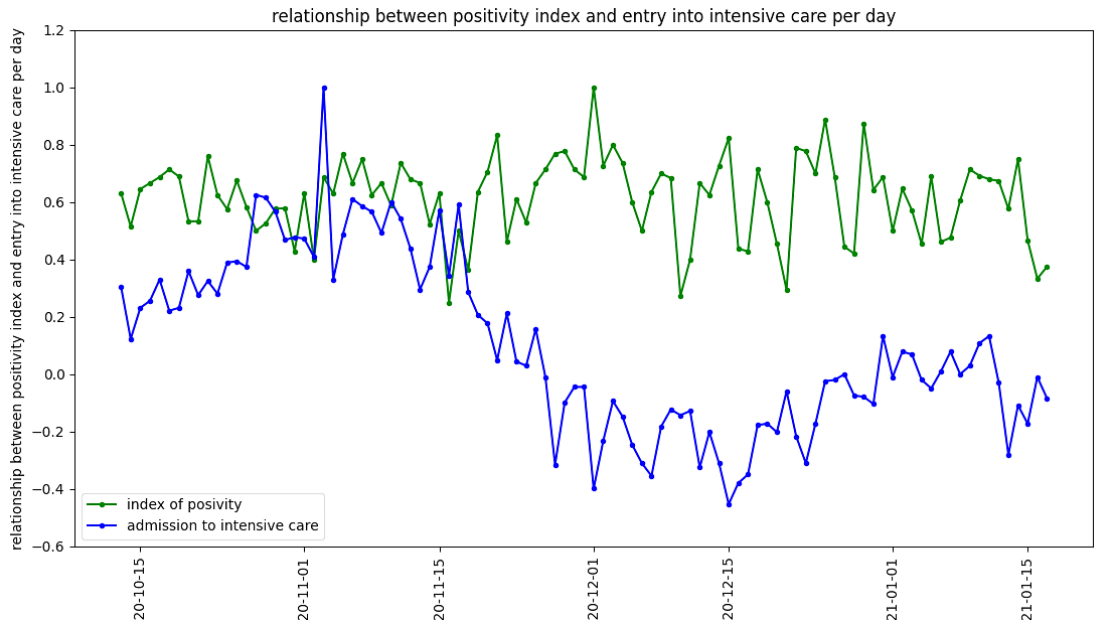
Figure 9. Index of positivity and admissions to daily intensive